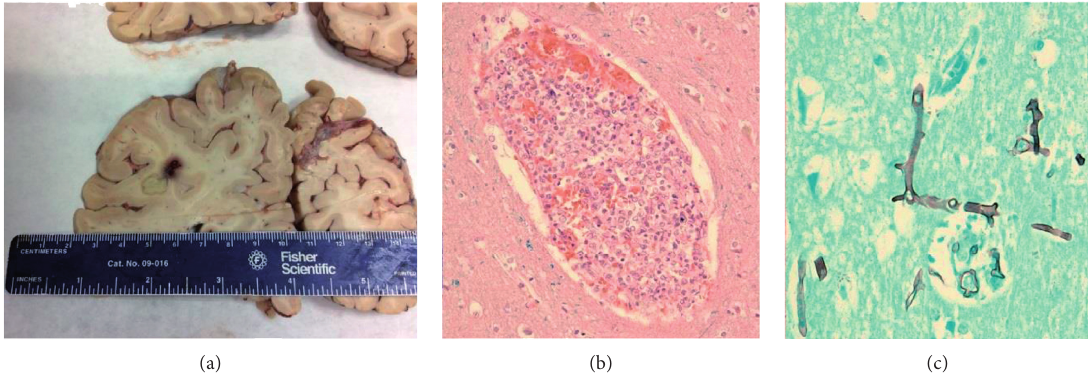
Figure 6: Autopsy: cerebral mucormycosis. Macroscopic appearance of temporal lobe abscess (a); abundant aseptate, wide-angled hyphae in blood vessels ((b), H&E stain) and brain parenchyma ((c), GMS stain).